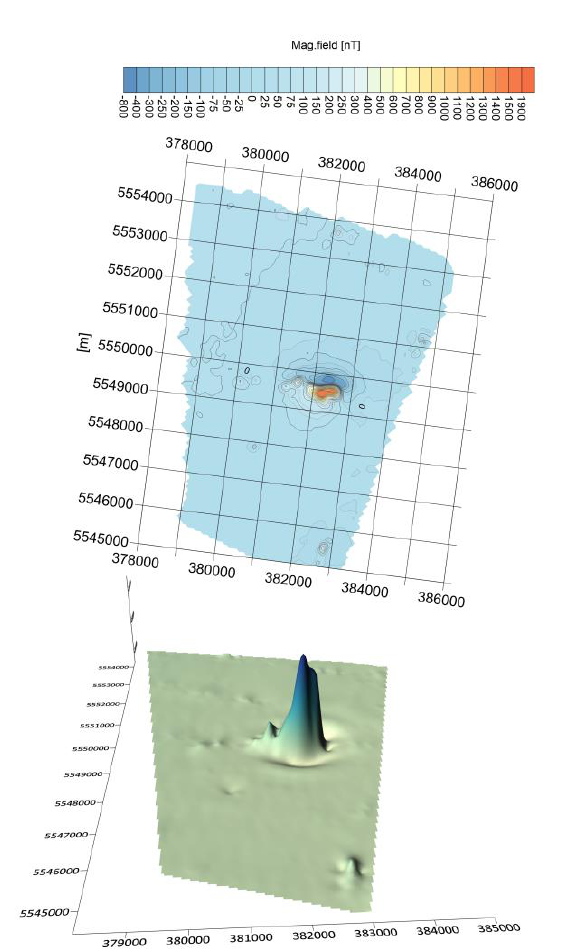
Figure 6. The example 3D and 2D presentation magnetic anomaly. The airborne measurement on the effusion of basalt (locality Blatno,